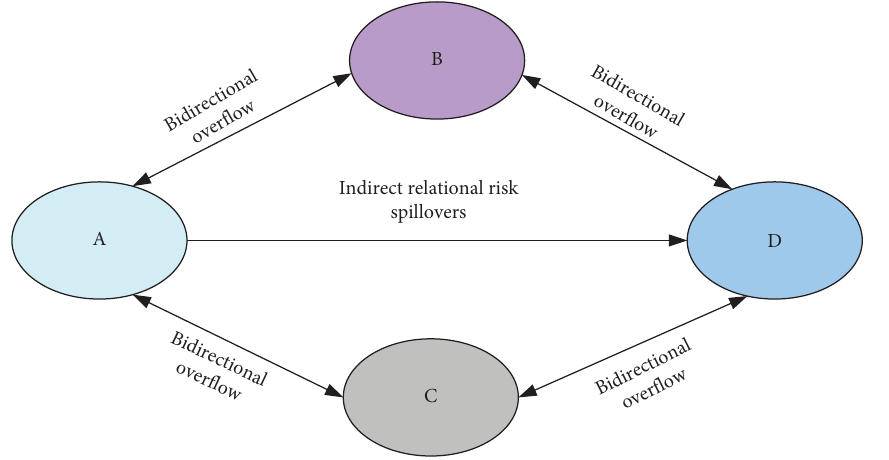
Figure 7: Financial risk spillover